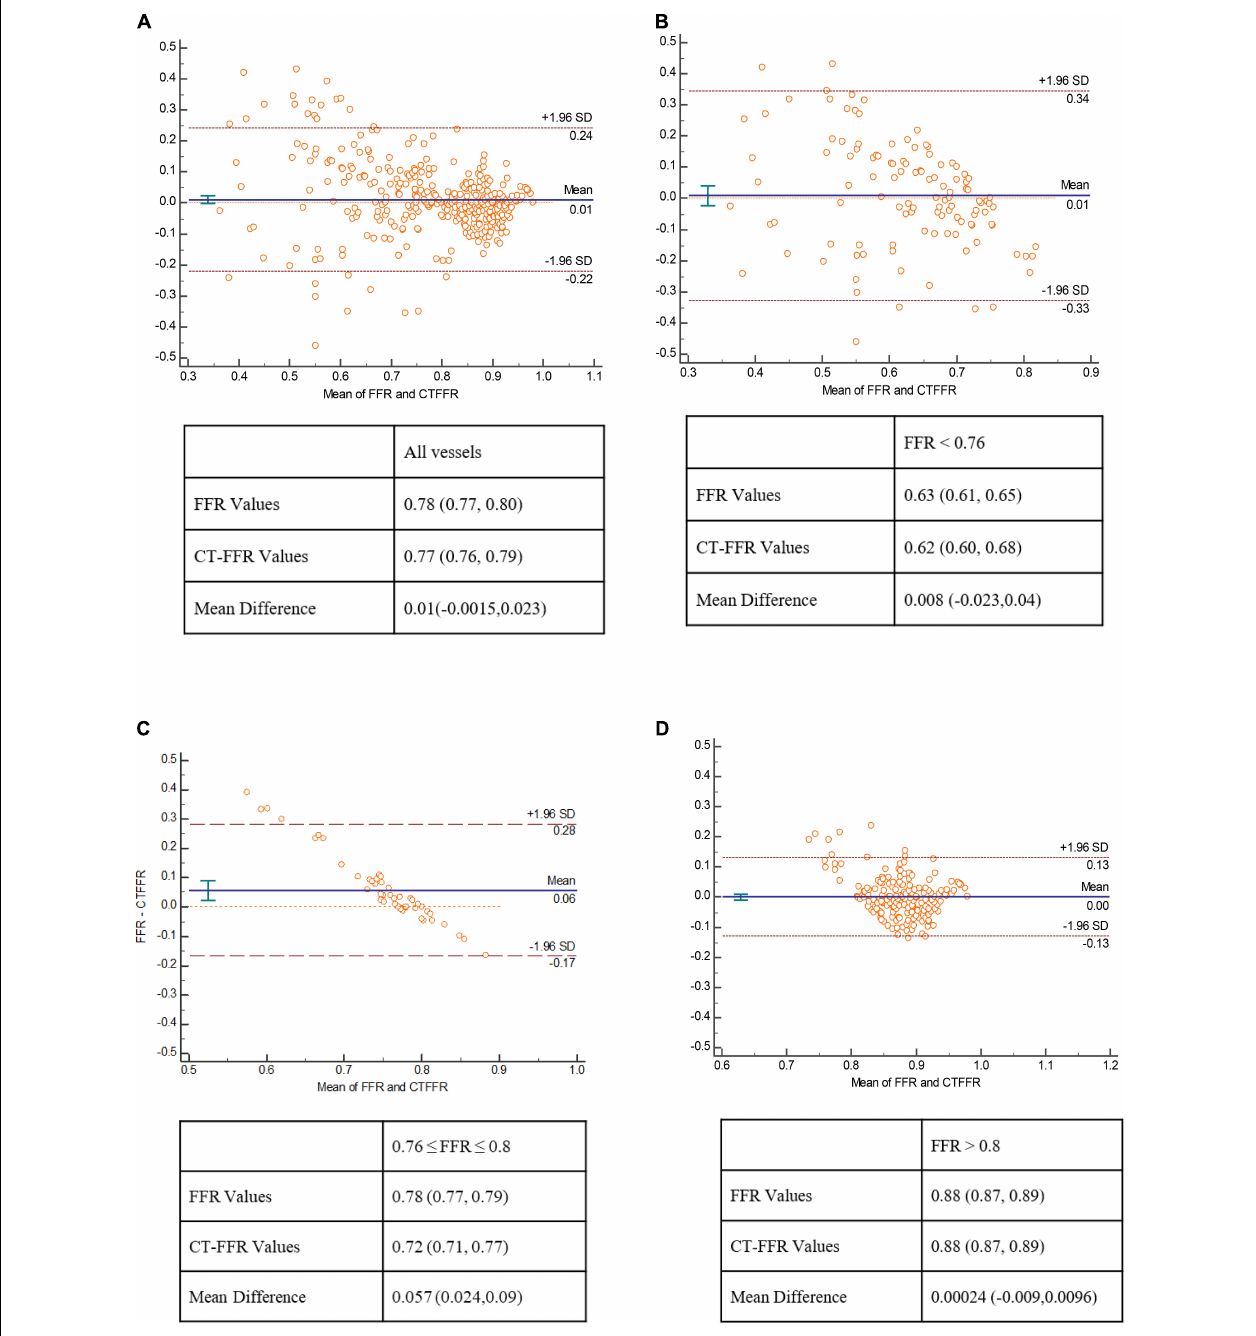
FIGURE 3 | Bland–Altman plot of CT-FFR and FFR. Bland–Altman analysis show a very mild systematic underestimation of CT-FFR with FFR values in all lesions (A) , and in lesions with FFR < 0.76 (B) , a relatively large underestimation of CT-FFR with FFR in gray zone lesions (C) , and a nearly equal value of CT-FFR and FFR in non-ischemia lesions (D)